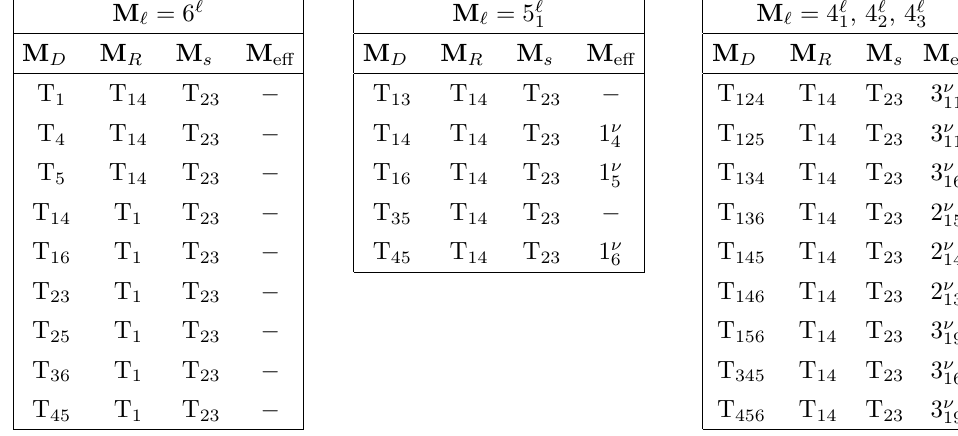
(centre) and 4 ‘ 1 1 , 2 , 3